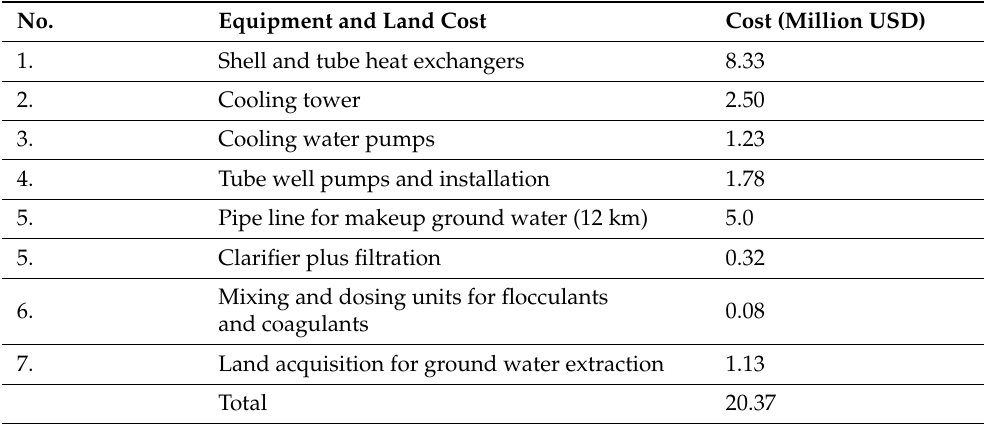
Table 3. Estimated equipment cost for the water cooling